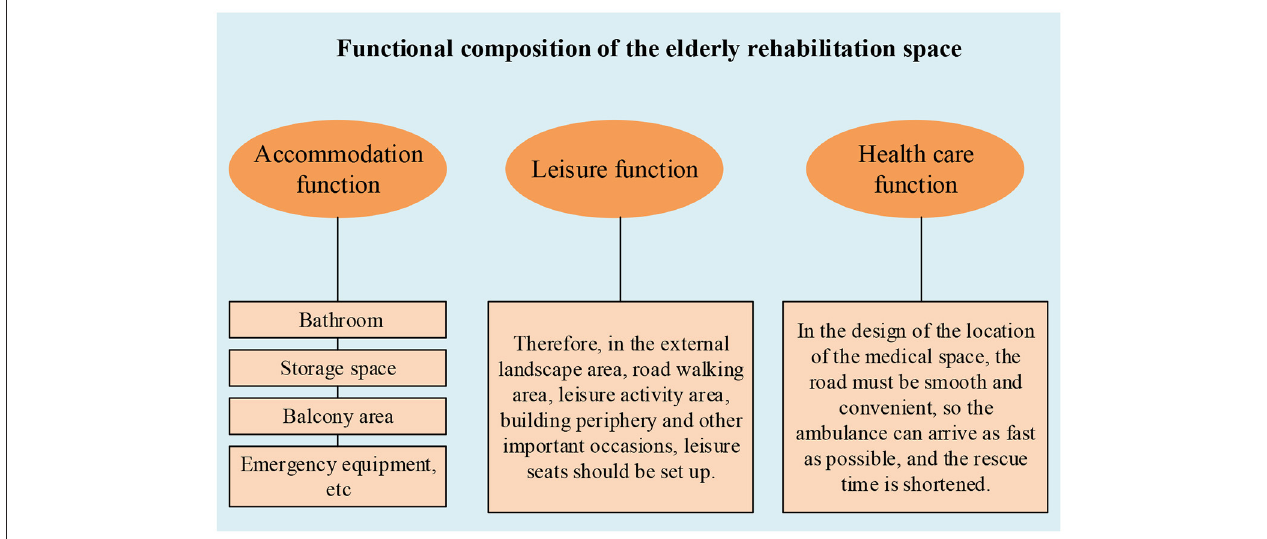
FIGURE 2 | The functional composition of the elderly rehabilitation